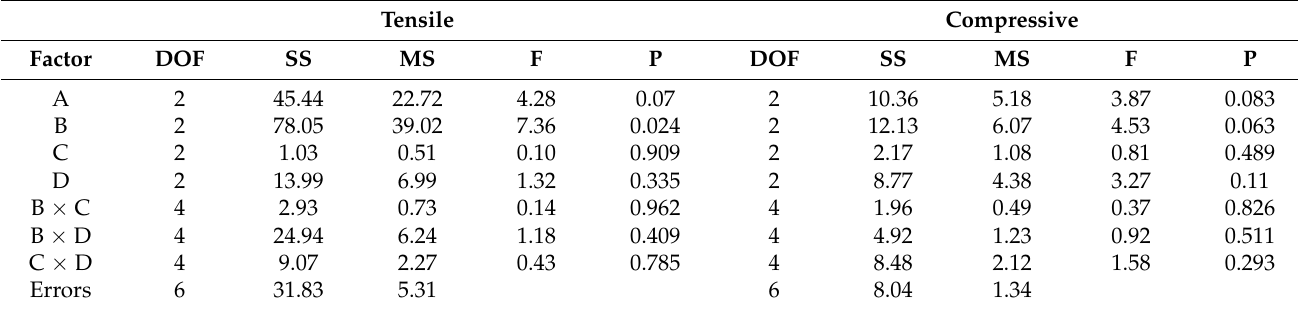
Table 4. ANOVA for mechanical strengths of Taguchi method.